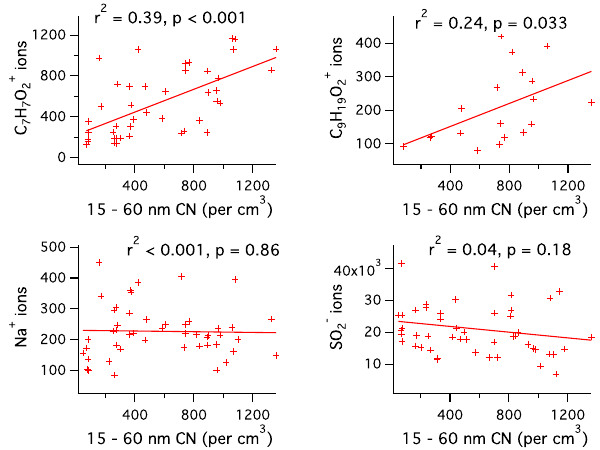
Figure 7. Correlations between individual species measured by TD- CIMS and the sum of ambient particle number (CN) in the range of 15–60nm during the period 22–28 May. Three points prior to midnight on 26 May were excluded, due to very high sulfate lev- els attributed to a volcanic plume. The ion most closely associated with the nanoparticle enhancement events is C 7 H 7 O + , most likely 2 benzoic acid. Inorganic salts are not correlated with the increases in particle number during this period. Coefficients of determination and p values for the linear fit slope are